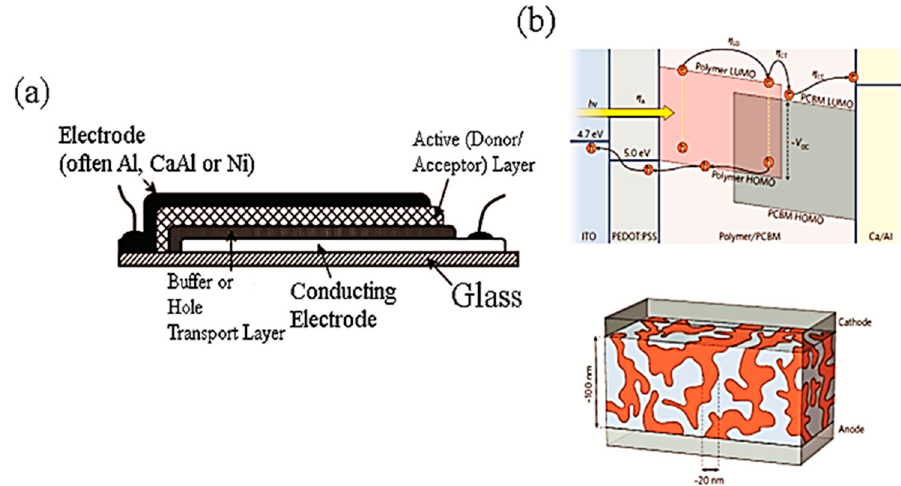
Figure 1. ( a ) Typical structure of a polymer based solar cell. Adapted from [34], Reproduced with permission; ( b ) The operating mechanism of an OPV with a model often presented for the network of the polymer and the acceptor. Adapted from [18], Reproduced with